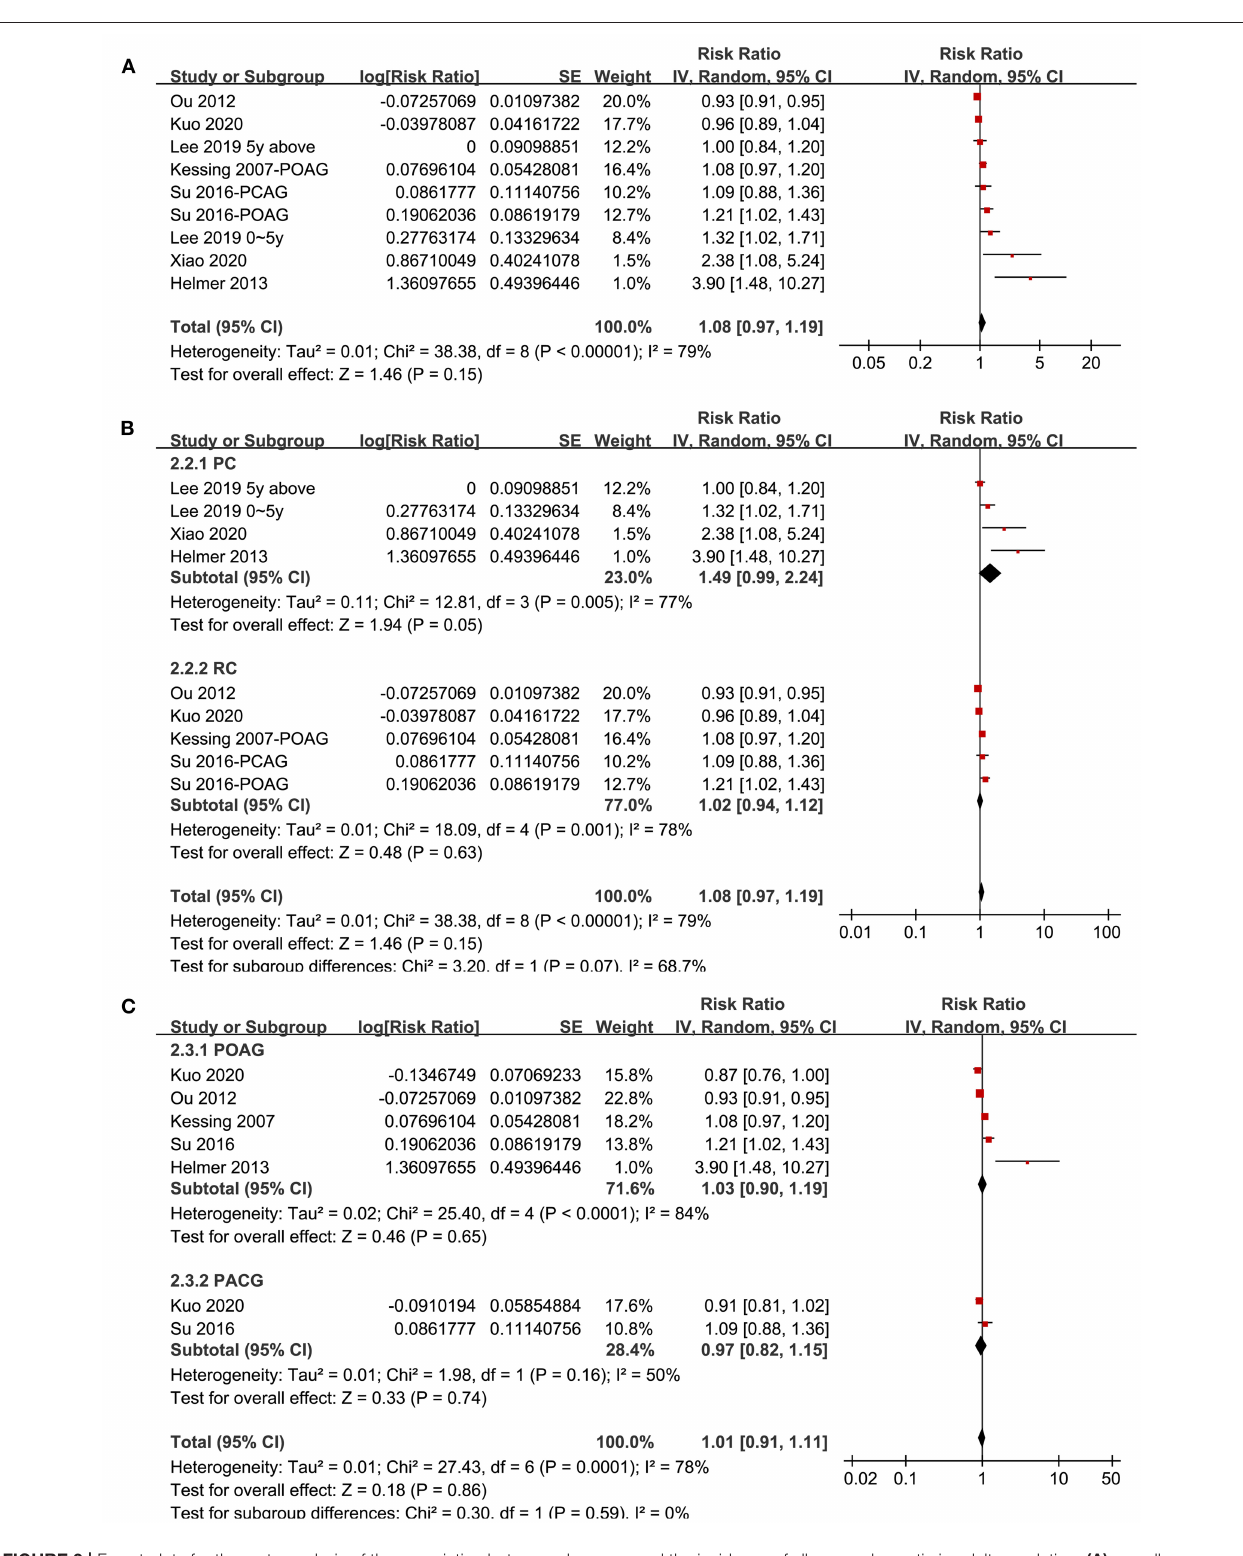
Frontiers in Medicine |